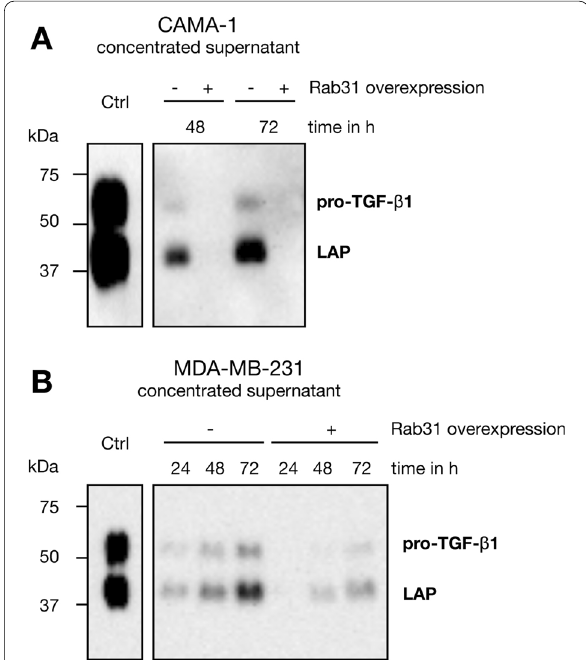
Fig. 6 Western blot analysis of TGF-ß1 in cell culture supernatants of Rab31 low- and high-expressing cells. Concentrated cell culture supernatants (concentration factor 1:16; the total protein content of the supernatants was used for normalization) of CAMA-1 ( A ) or MDA-MB231 ( B ) Rab31 overexpressing and vector control cells, respectively, were reacted with a TGF-ß1 specific antibody. The signals obtained match the expected size for pro-TGF-ß1 and its cleavage product LAP, respectively Fig. 7 TGF-ß activity assays of cell culture supernatants from Rab31 the respective vector transfectants displaying only low endogenous Rab31 levels. We identified 9 differentially